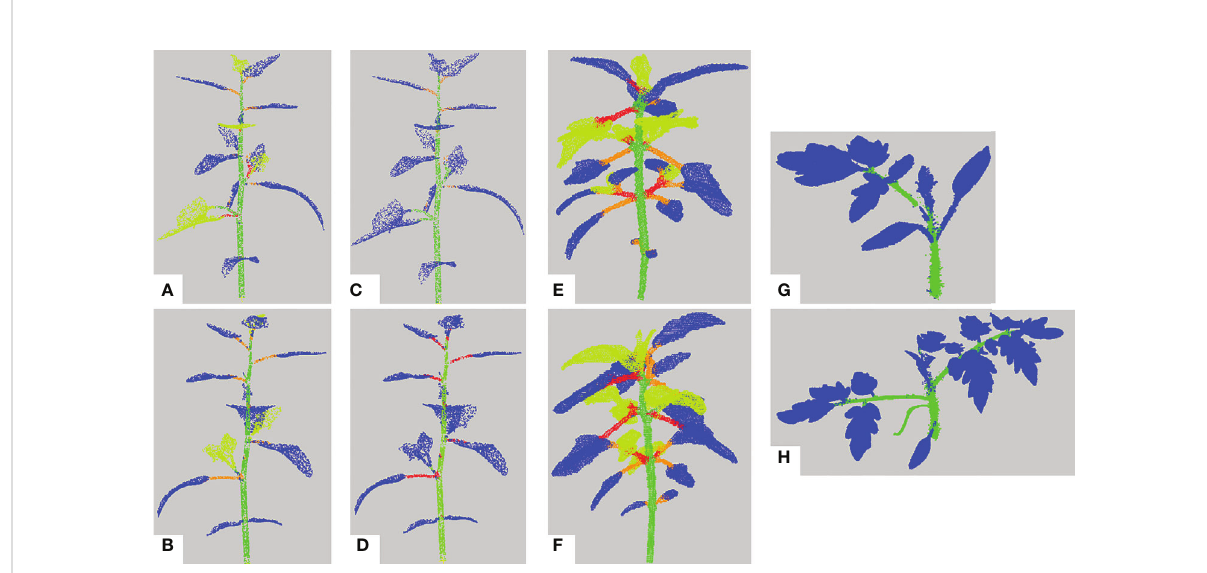
FIGURE 9 Semantic segmentation results. (A, B) Semantic segmentation of two different synthetic Chenopodiums. Points labelled in blue, (resp. green, orange, red, yellow) correspond to leaf blade (resp. stem, petiole, branch, apex) labels. (C, D) Same segmentations as in a) and b) where labels of the apex class have been relabeled as leaf blades. (E, F) Semantic segmentation of two real Chenopodiums. (G, H) Semantic segmentation of two real tomato